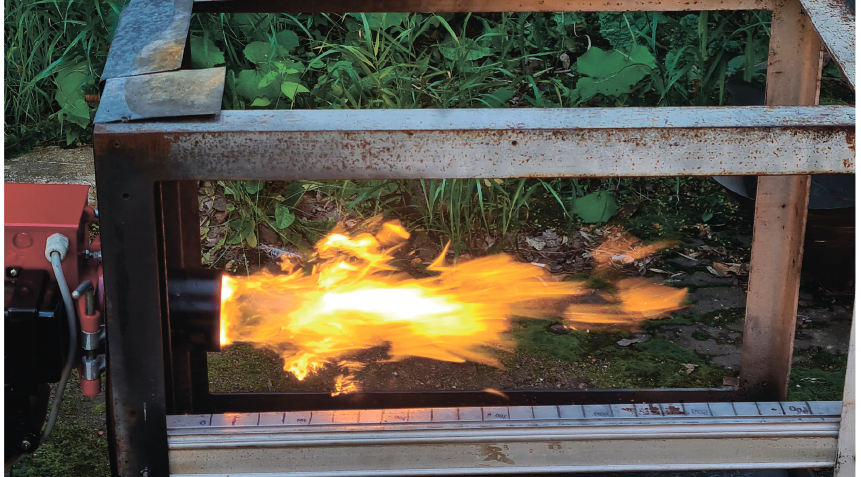
Figure 11. Diesel fuel combustion in OILON burner.